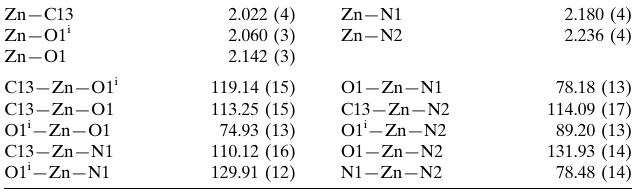
Selected geometric parameters (A˚ , (cid:3)